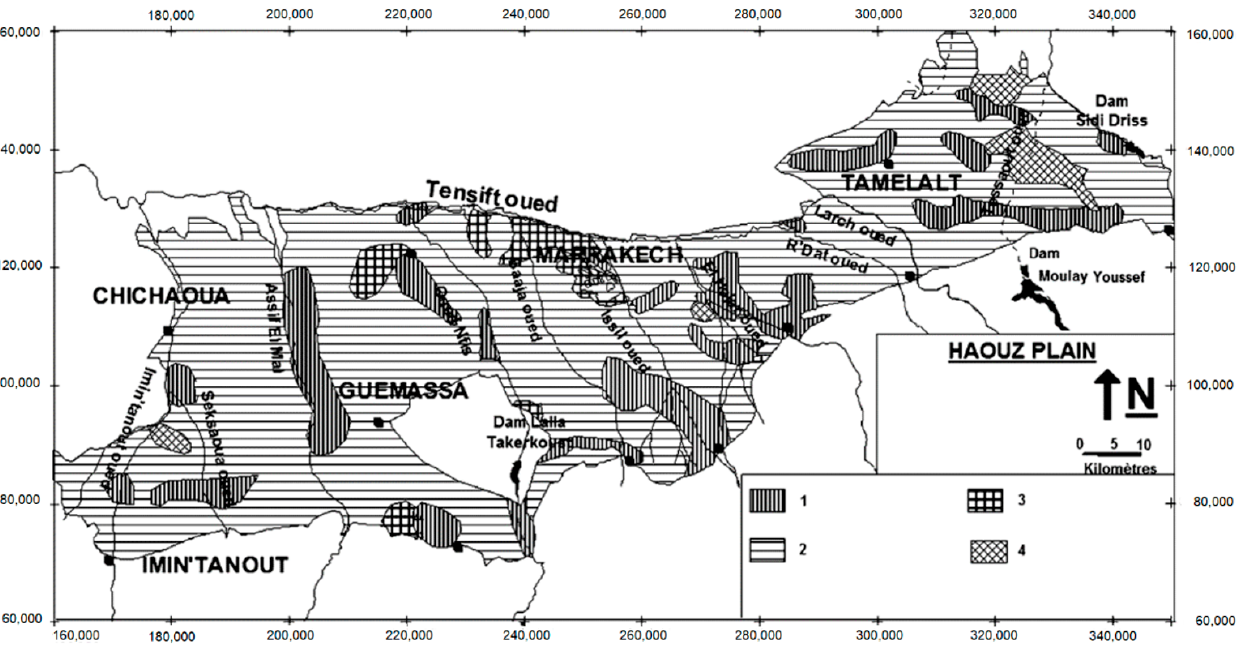
Figure 2. Lithological facies of the saturated zone of the Haouz aquifer; 1 Coarse alluvia (pebbles, gravels, sands); 2 heterogeneous alluvia (pebbles, gravels, sands, clays, marls); 3 alluvia with calcareous intercalations; 4 conglomerates [28] .